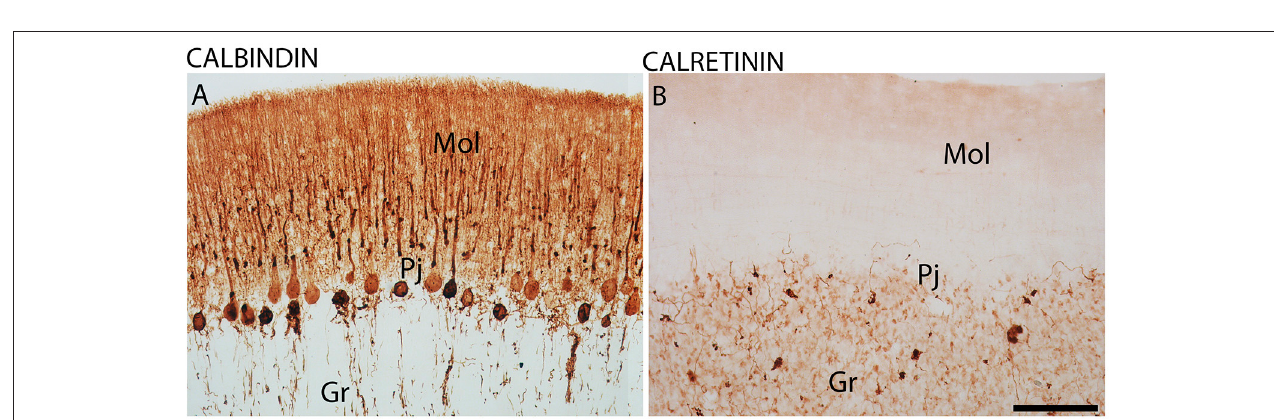
FIGURE 5 | The distribution of calretinin (CR) protein in the cerebellar cortex in the primate Sapajus apella . Photomicrographs of frontal brain sections show CR-IR with significant expression in the granular layer (A–F) at two time points, one during the day (ZT 10) (A–C) and another at night (ZT 19) (D–F) . The CR-IR showed day/night variations in IR intensity (O.D) in the cells in the granular layer (G) . Bar = 100 µ m. Purkinje cell layer (Pj); molecular layer (mol); granular layer (Gr).